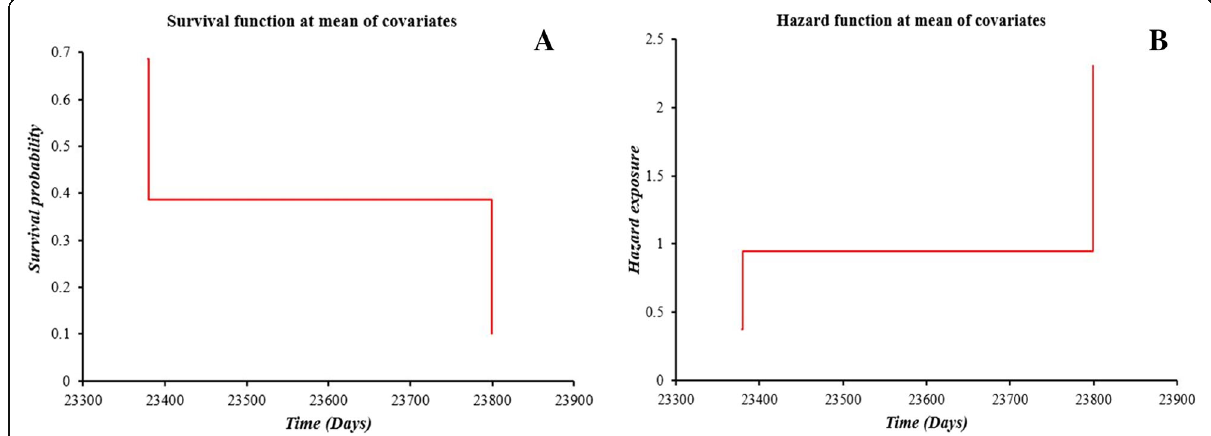
Fig. 13 Survival probability ( A ) and hazard exposure ( B ) of the five landslide occurrence sites